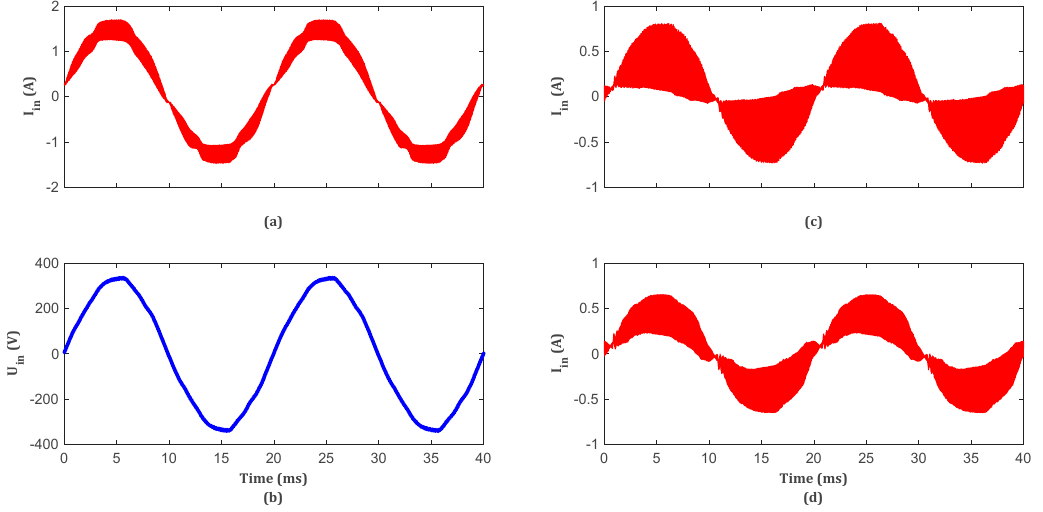
Figure 18. Experimental waveforms of input current ( a ) and voltage ( b ) at P = 200 W; ( c ) input current at P = 50 W ( γ = 0.25 and f = 64 kHz); ( d ) input current at P = 50 W ( γ = 0.35 and f = 150 kHz).